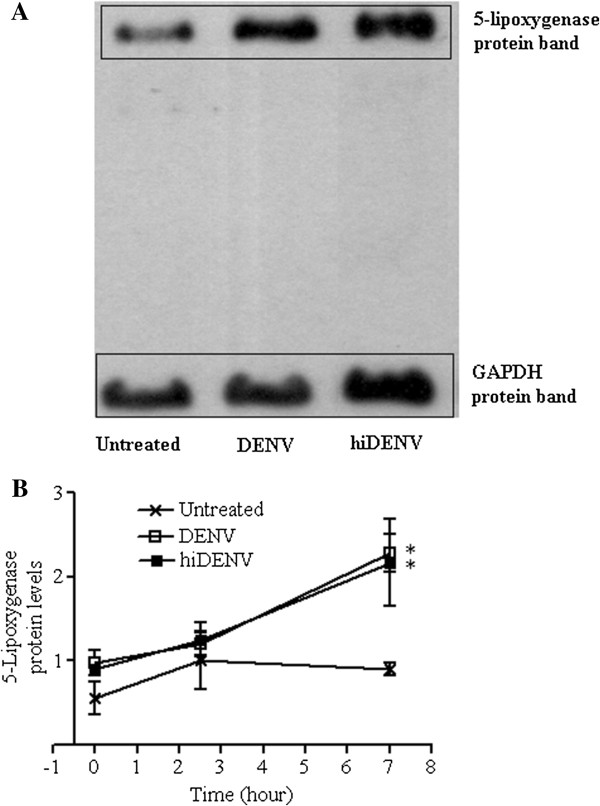
5-Lipoxygenase expression by neutrophils incubated with or without dengue viruses. The proteins were isolated from neutrophils and were electrophoretically transferred from the gel onto Hybond-C Extranitrocellulose membrane. The membrane was then cut, based on the size of proteins of interest, to separate the 5-lipoxygenase (79 kDa) and the control protein GAPDH (39 kDa). (A) Representative films from 5-lipoxygenase and GAPDH Western blots performed with untreated neutrophils and neutrophils incubated with live (DENV-2) or heat-inactivated dengue viruses (hiDENV-2). (B) Expression of 5-lipoxygenase protein by untreated neutrophils (×) and neutrophils exposed to live (DENV-2, □) or heat-inactivated dengue viruses (hiDENV-2, ■) (N = 3). * p < 0.05 vs untreated cells using one-way ANOVA analysis of the area under the curves with Bonferroni adjustments.